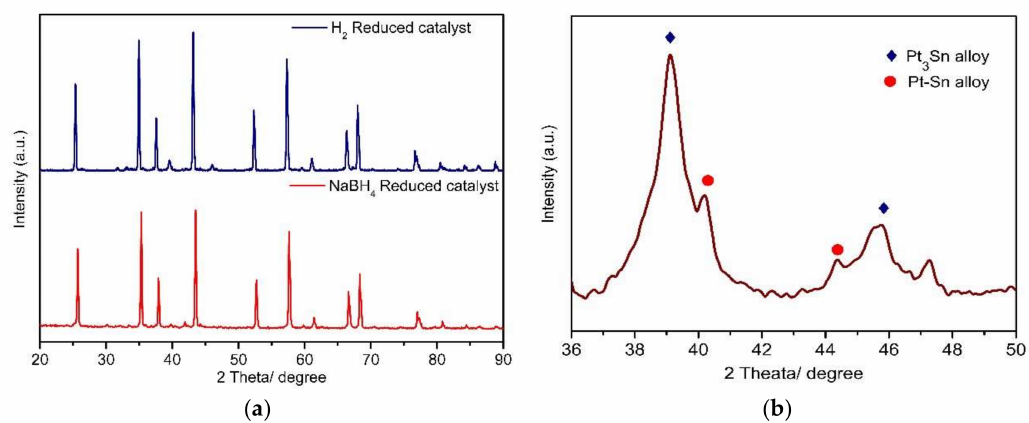
Figure 2. X-ray di ff raction (XRD) patterns of ( a ) Pt–Sn / Al 2 O 3 NaBH 4 and H 2 reduced catalyst and ( b ) Pt–Sn precursor without alumina